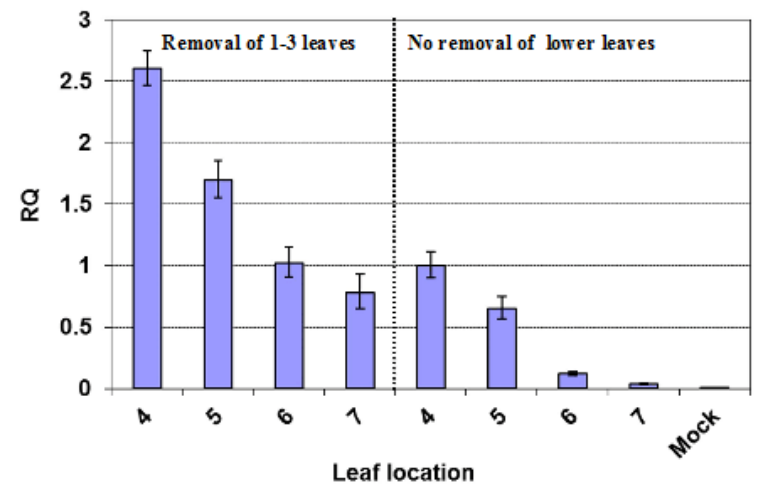
Figure 4. Effects of removal of earlier leaves on symptoms and virus level in latter leaves of tobacco plants infected with PVY N:O -Mb58. ( A ) Symptoms in plants with (R) and without (NR) the removal of the +1 to +3 leaves; ( B ) Leaves at +4 to +7 node position at the leaf age of 12 days post-emergence (dpe) from plants with and without the removal of the leaves at +1 to +3 node position; ( C ) Relative PVY level (RQ) in leaves. The virus level was obtained using real-time RT-PCR analysis of PVY upon normalization with the COX1 level in the